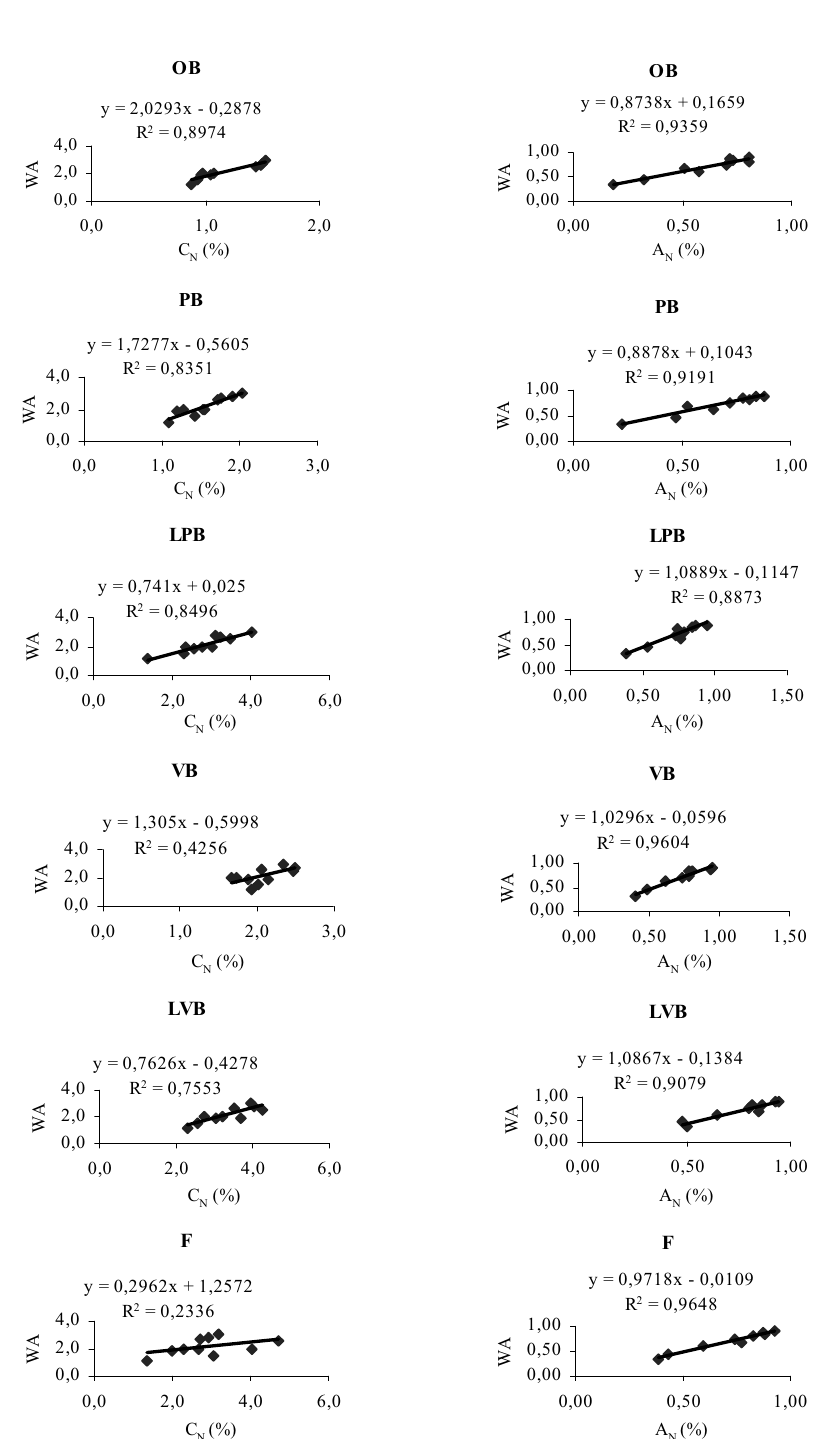
An Acad Bras Cienc (2007) 79